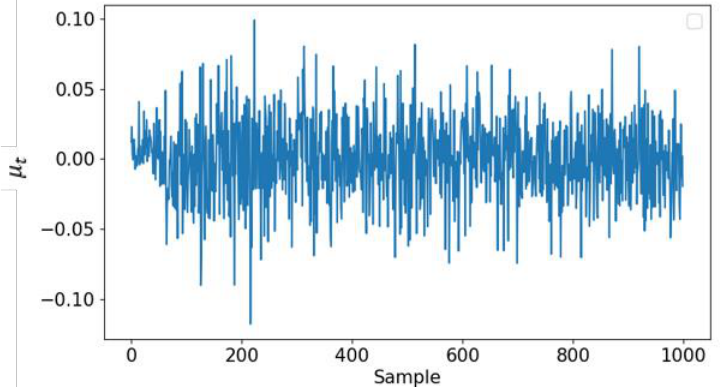
Figure 5. Residual sequence of transformed data.